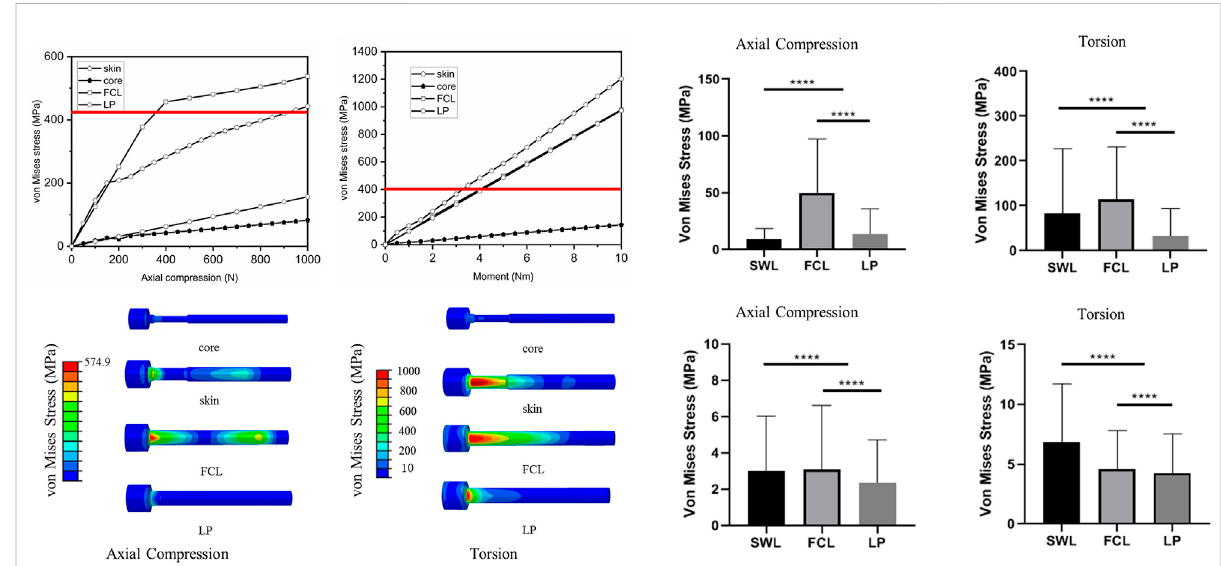
FIGURE 5 The von Mises stress results for the three constructs. (A,B) Under axial compression and torsion load, the maximum von Mises stress of each screw varies with load and the allowable stress of titanium alloy (red line). (C,D) Maximum von Mises stress cloud diagram of each screw